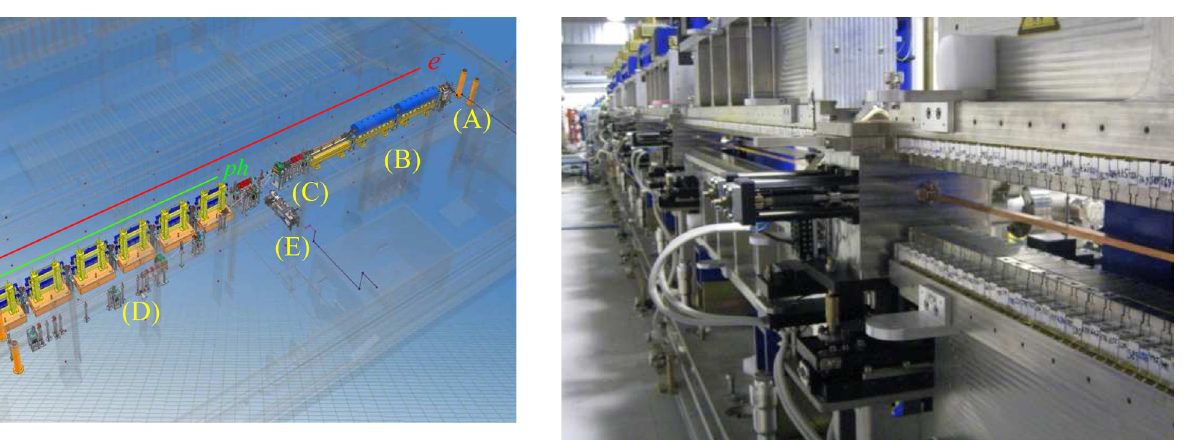
FIG. 3. SPARC undulator consisting of six sections made by 75 periods of 2.8 cm each (77 periods including two termination periods), with gaps variable in the range from 25 to 8.4 mm (limited by the vacuum chamber) corresponding to a maximum (cid:1) 2 : 2 (see definition below) at the undulator parameter K u minimum